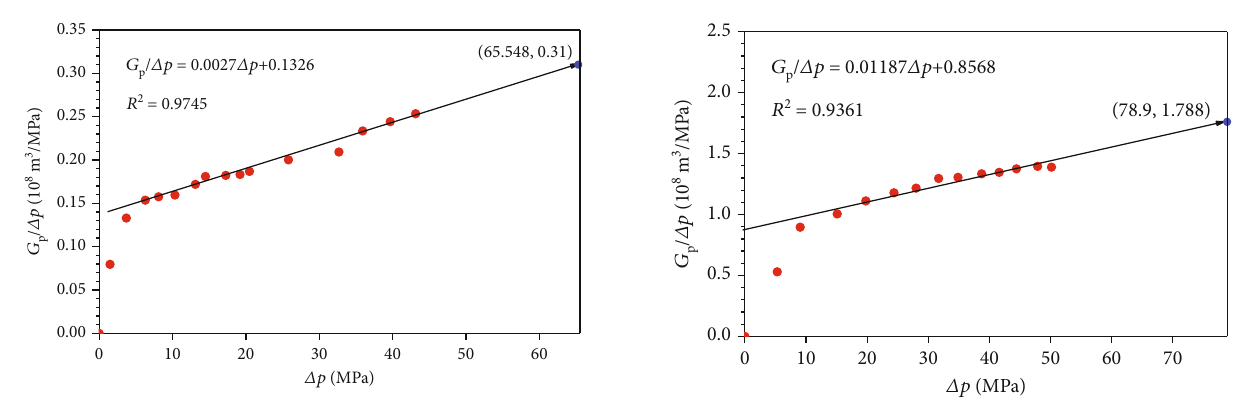
Figure 6: Reserves of Louisiana o ff shore gas reservoir calculated by the method of gas production of cumulative unit pressure